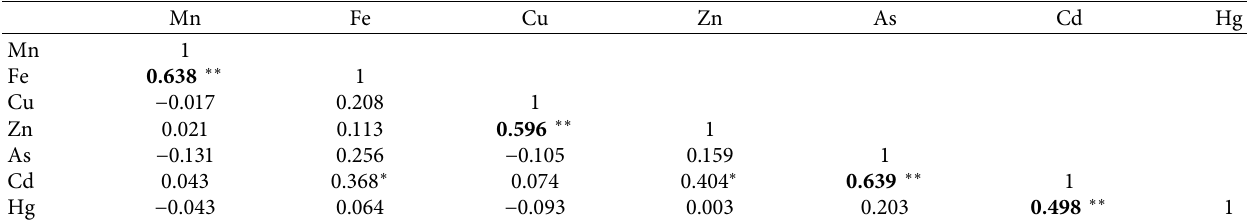
Table 5: Correlation between seven trace metal elements of 35 observed samples.